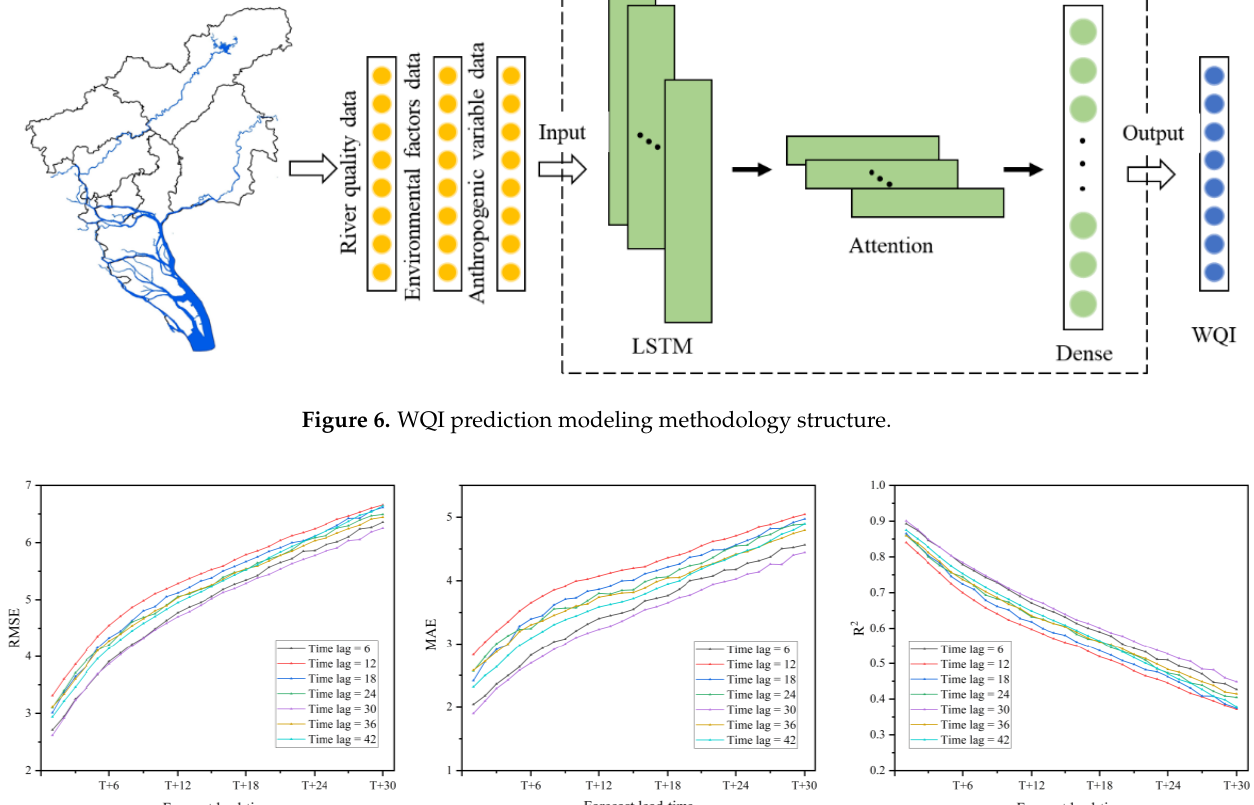
Figure 7. Effect of time lag for different forecast lead-times.